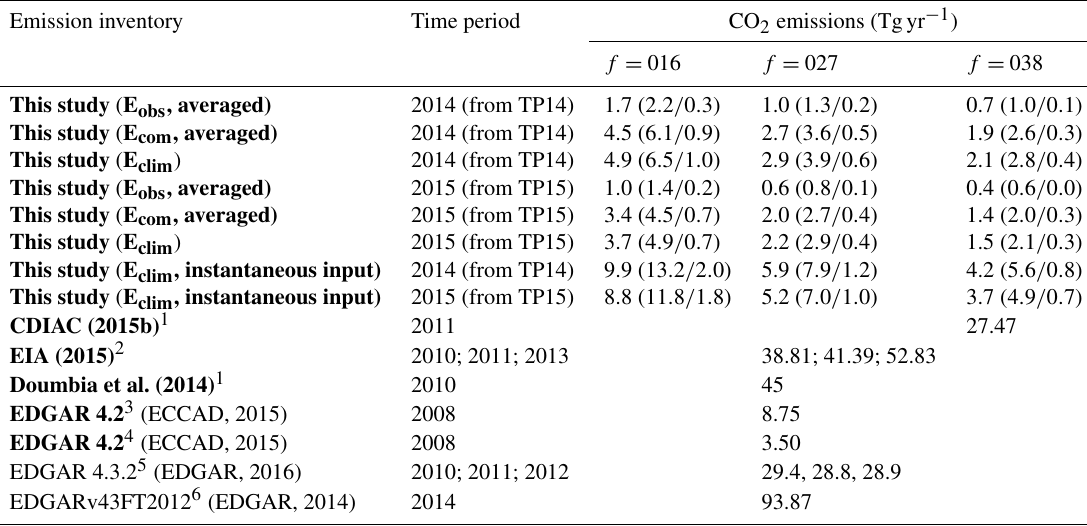
Table 4. Comparison between existing emission inventories for CO 2 (with a focus on gas flaring if available) and the results of this study for Nigeria in teragrams (Tg) per year. For TP14 and TP15 it is assumed that the 2-month observations represent the flaring conditions of the whole year 2014 and 2015, respectively. Therefore, the emissions were integrated to yearly values. The domain of uncertainty arising from the UP14 parameters and the spatial variability in total hydrocarbon is given in parentheses. For the fraction of radiated heat f , the mean value 0.27 and the lower (upper) boundary of 0.16 (0.38) are used, representing a further source of uncertainty. The products given in bold are directly related to flaring